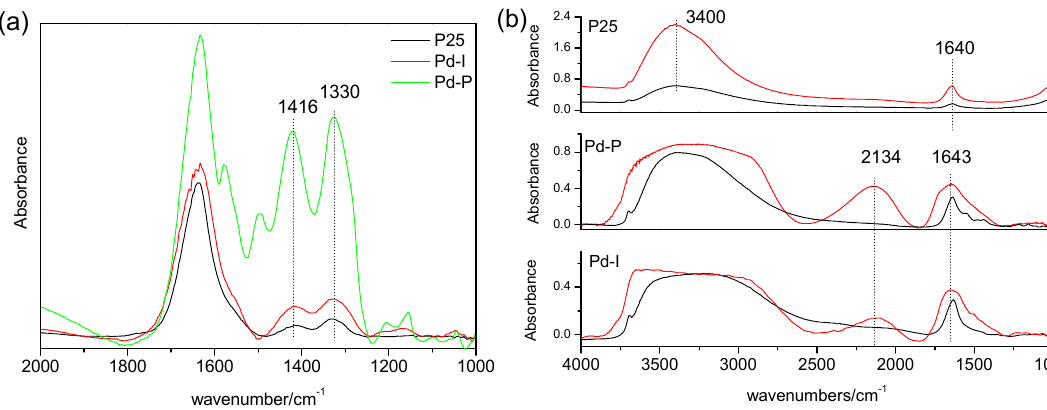
Figure 9. ( a ) FTIR spectra obtained after 15 h of the reaction of NO elimination at 65% RH. ( b ) FTIR spectra of the catalysts (black) and the catalysts subjected to a pure airflow at 65% RH (red) .